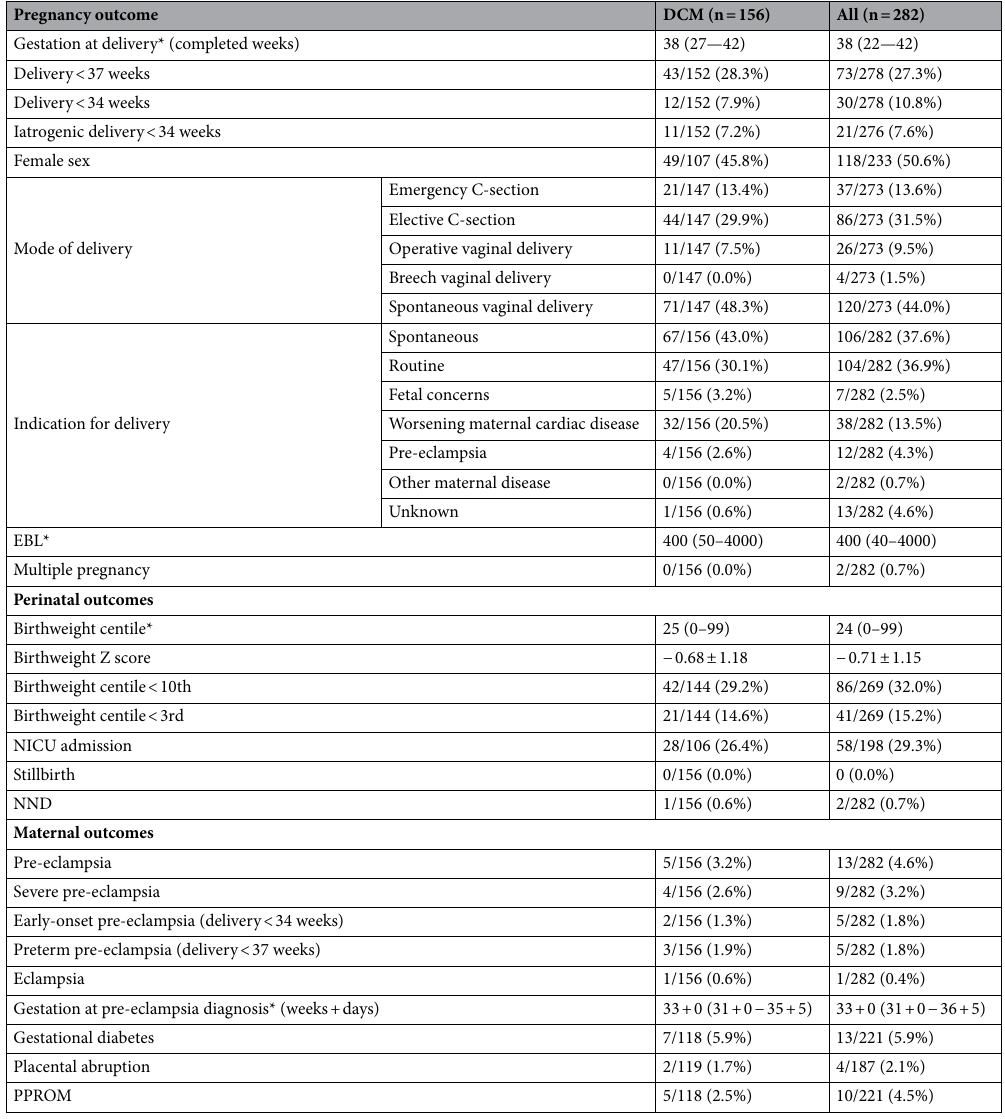
Table 3. Pregnancy outcomes of the cohort. Frequencies: n/N (%). *Median (range). Denominators vary between variables due to missing data. EBL Estimated blood loss, NICU Neonatal intensive care, NND Neonatal death, HELLP Haemolysis, elevated liver enzymes and low platelets; PPROM, premature rupture of